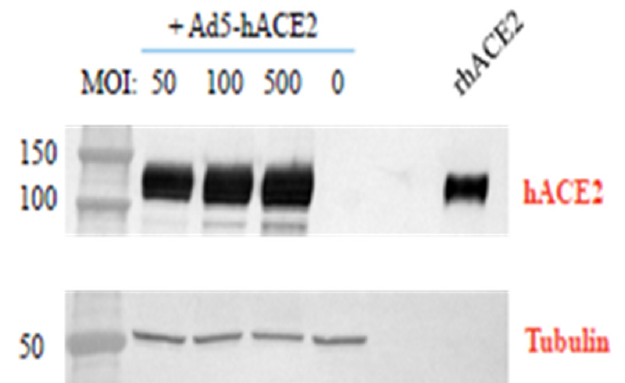
Figure 1. Western blot analysis of hACE2 expression in transfected A549 cells at 48 h. After 48 h of culture, A549 cells were harvested and the cell pellet was prepared for Western blot analysis, utilising a monoclonal antibody for human ACE2 detection and an anti-tubulin antibody (as a gel-loading control); a recombinant human ACE2 protein (125 ng) was used as a positive control. Non-trans- duced cell lysates were negative for hACE2 expression and tubulin was detected in all cell lysates at the expected size of approximately 50 kDa (the band is composed of alpha-tubulin (52 kDa) and/or the heterodimer (55 k Da)).